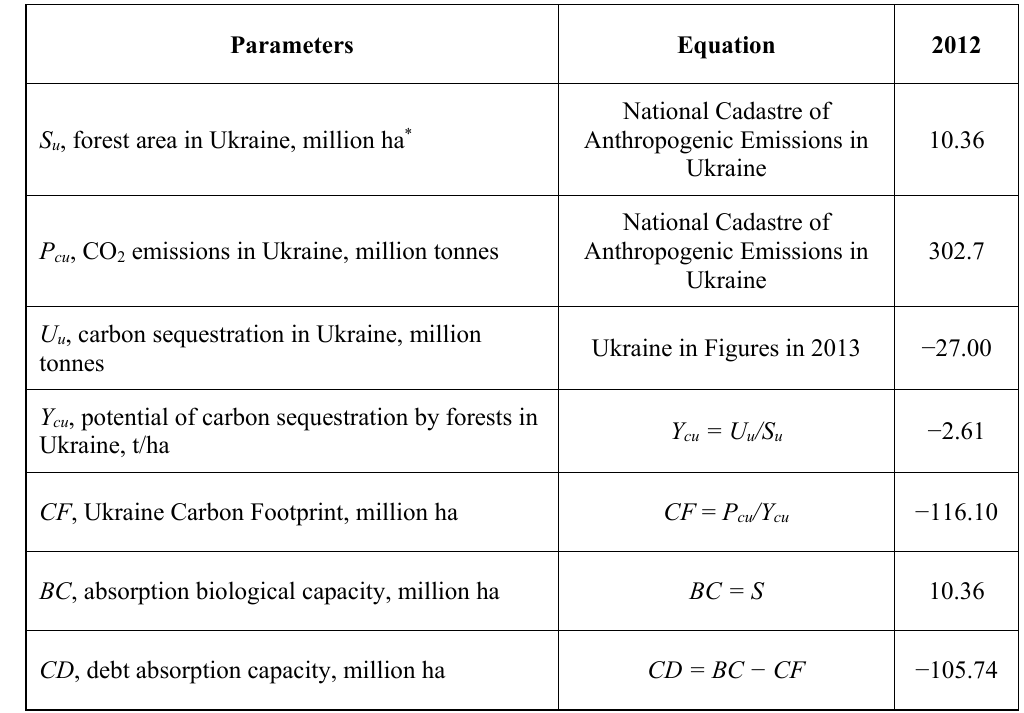
Table 1. Calculation of Carbon Footprint of Ukraine (Nekrasenko, Prokopenko, & Aranchiy,